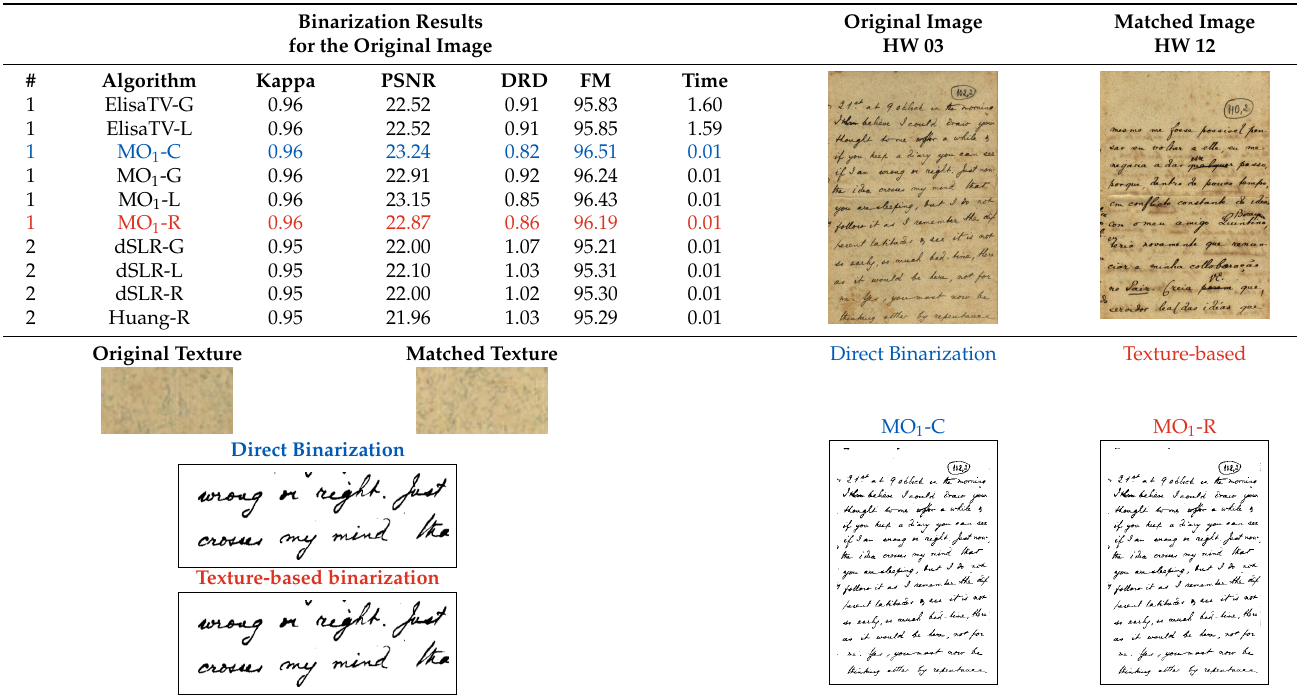
Table 6. Results for image matching with image HW 03.